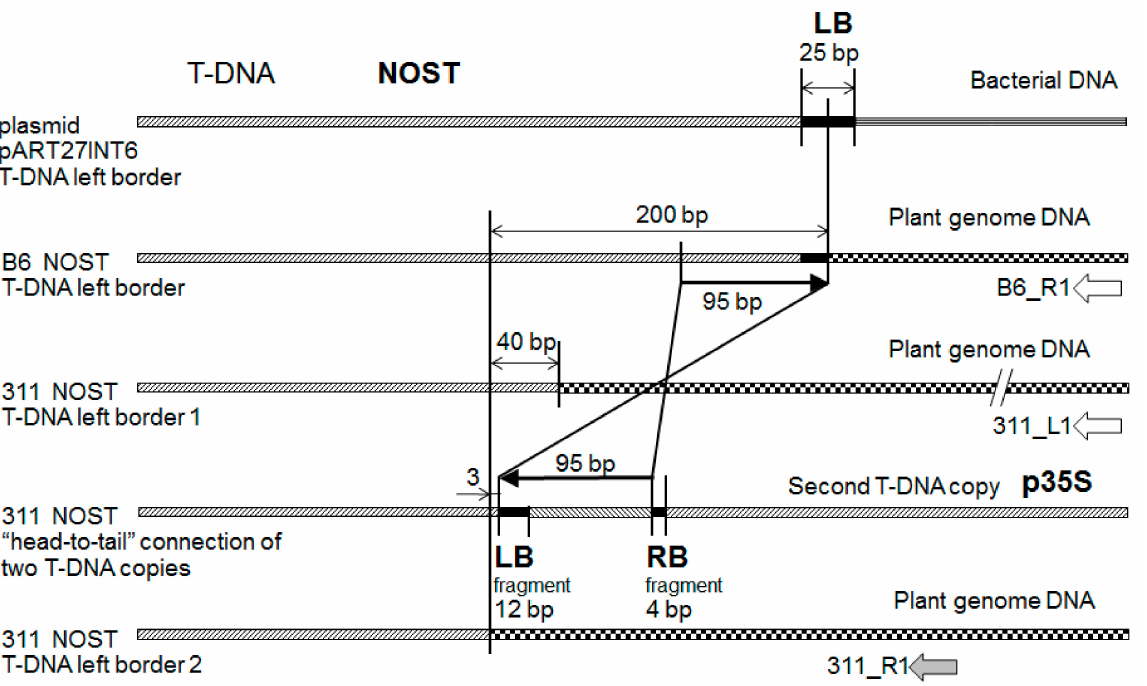
Figure 6. Scheme of T-DNA and genomic DNA junctions, as well as the junction point of inserts from line